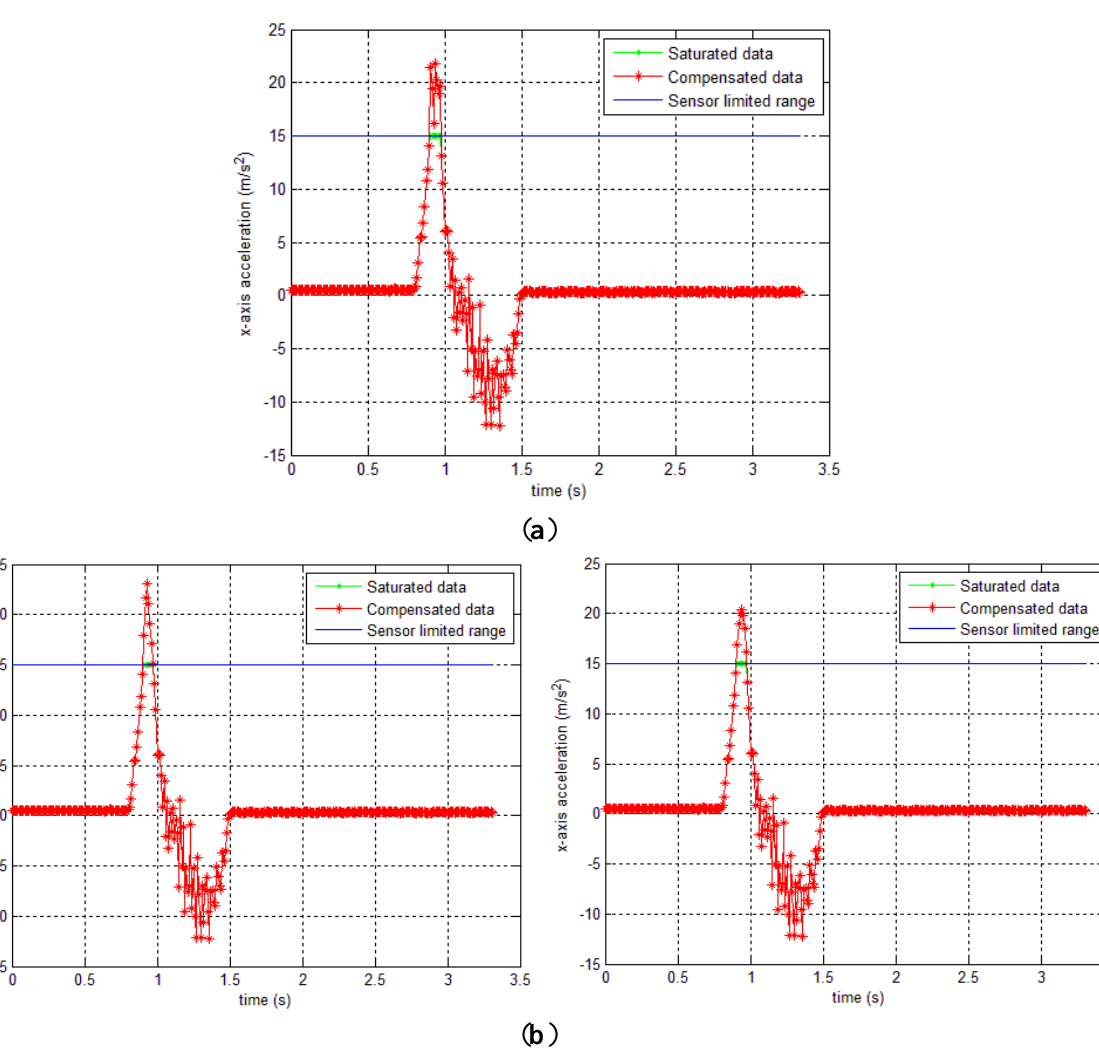
Proposed smoother (method 2: quadratic approximation) y sensor’s output and compensated data of 0.95 m straight movement Figure 12. , , a x k experiment; ( a ) method 1 result; ( b ) method 2 results (triangle and quadratic